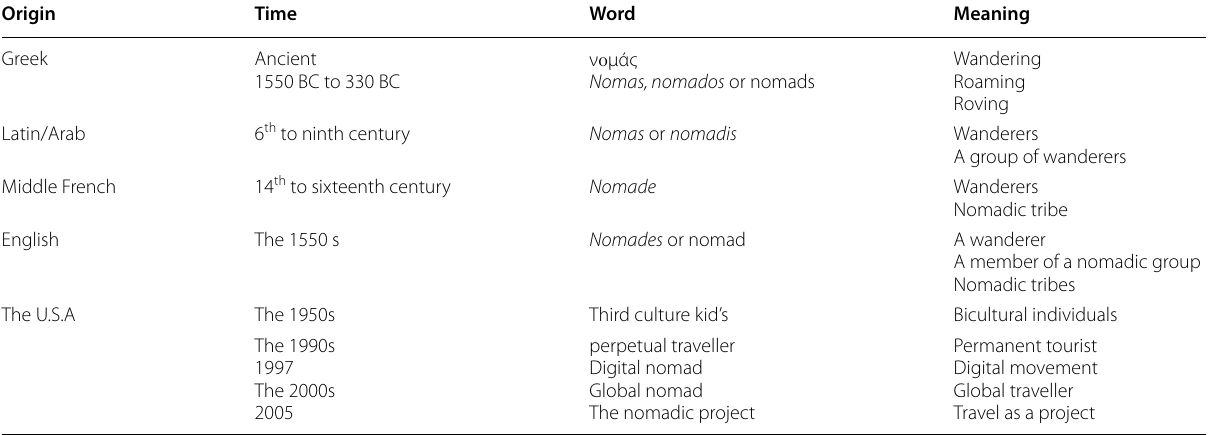
Table 1 Linguistic transformation of the word